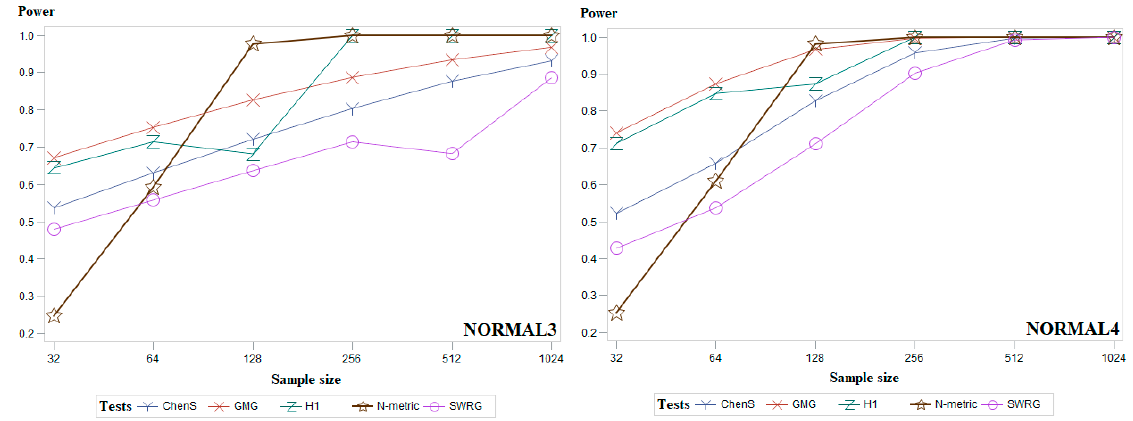
Figure A3. Average empirical power results for the examined sample sizes for the groups of the modified normal distributions of five powerful goodness-of-fit tests.